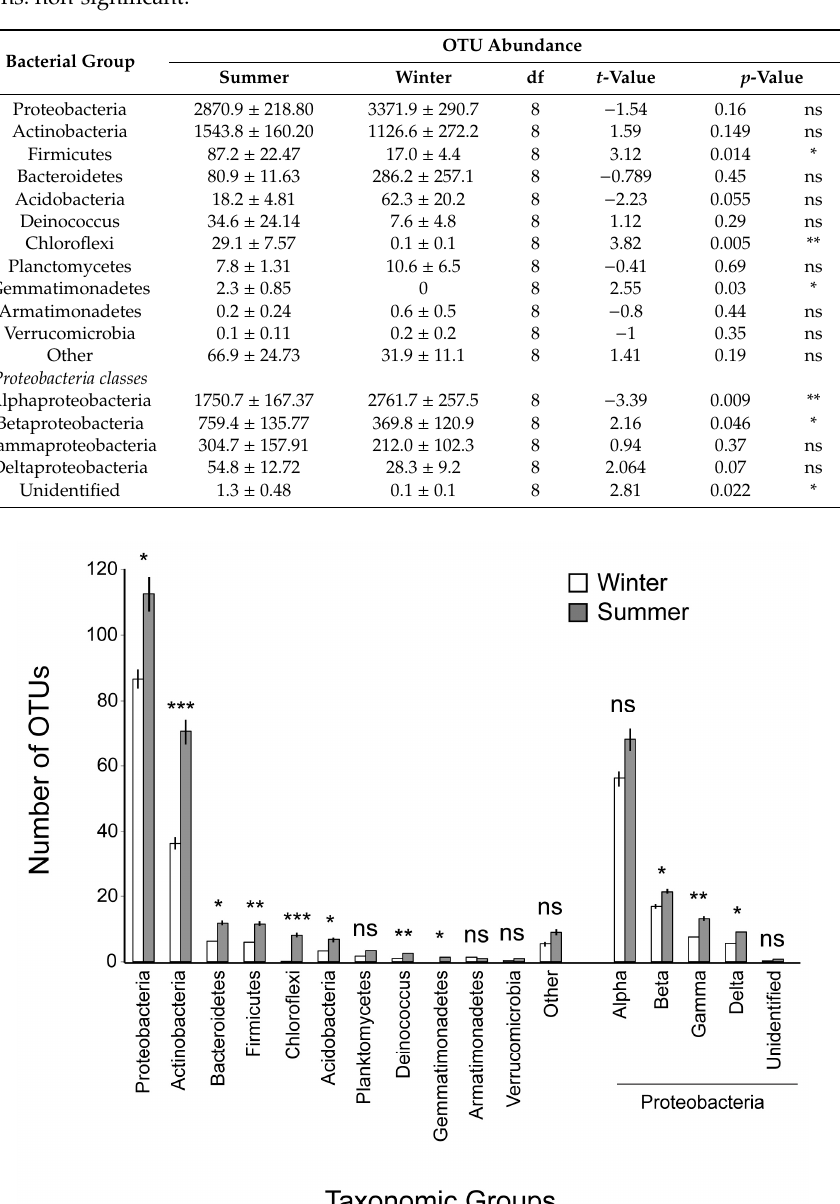
Table 3. Paired t-test results for OTU abundance between summer and winter for the major high-level taxonomic groups of bacteria represented in the phyllosphere bacterial community of the Mediterranean ecosystem studied. Under ‘Other’, Latescibacteria, Nitrospirae, Saccharibacteria, Spirochaetae, the WD272 group and unknown bacteria are included. For Gemmatimonadetes, with zero values in winter, we tested whether summer values di ff ered on average significantly from 0. For each bacterial group compared, the mean values and their standard errors are given; d.f.: degrees of freedom; *: p < 0.05; **: p < 0.01; ns: non-significant.